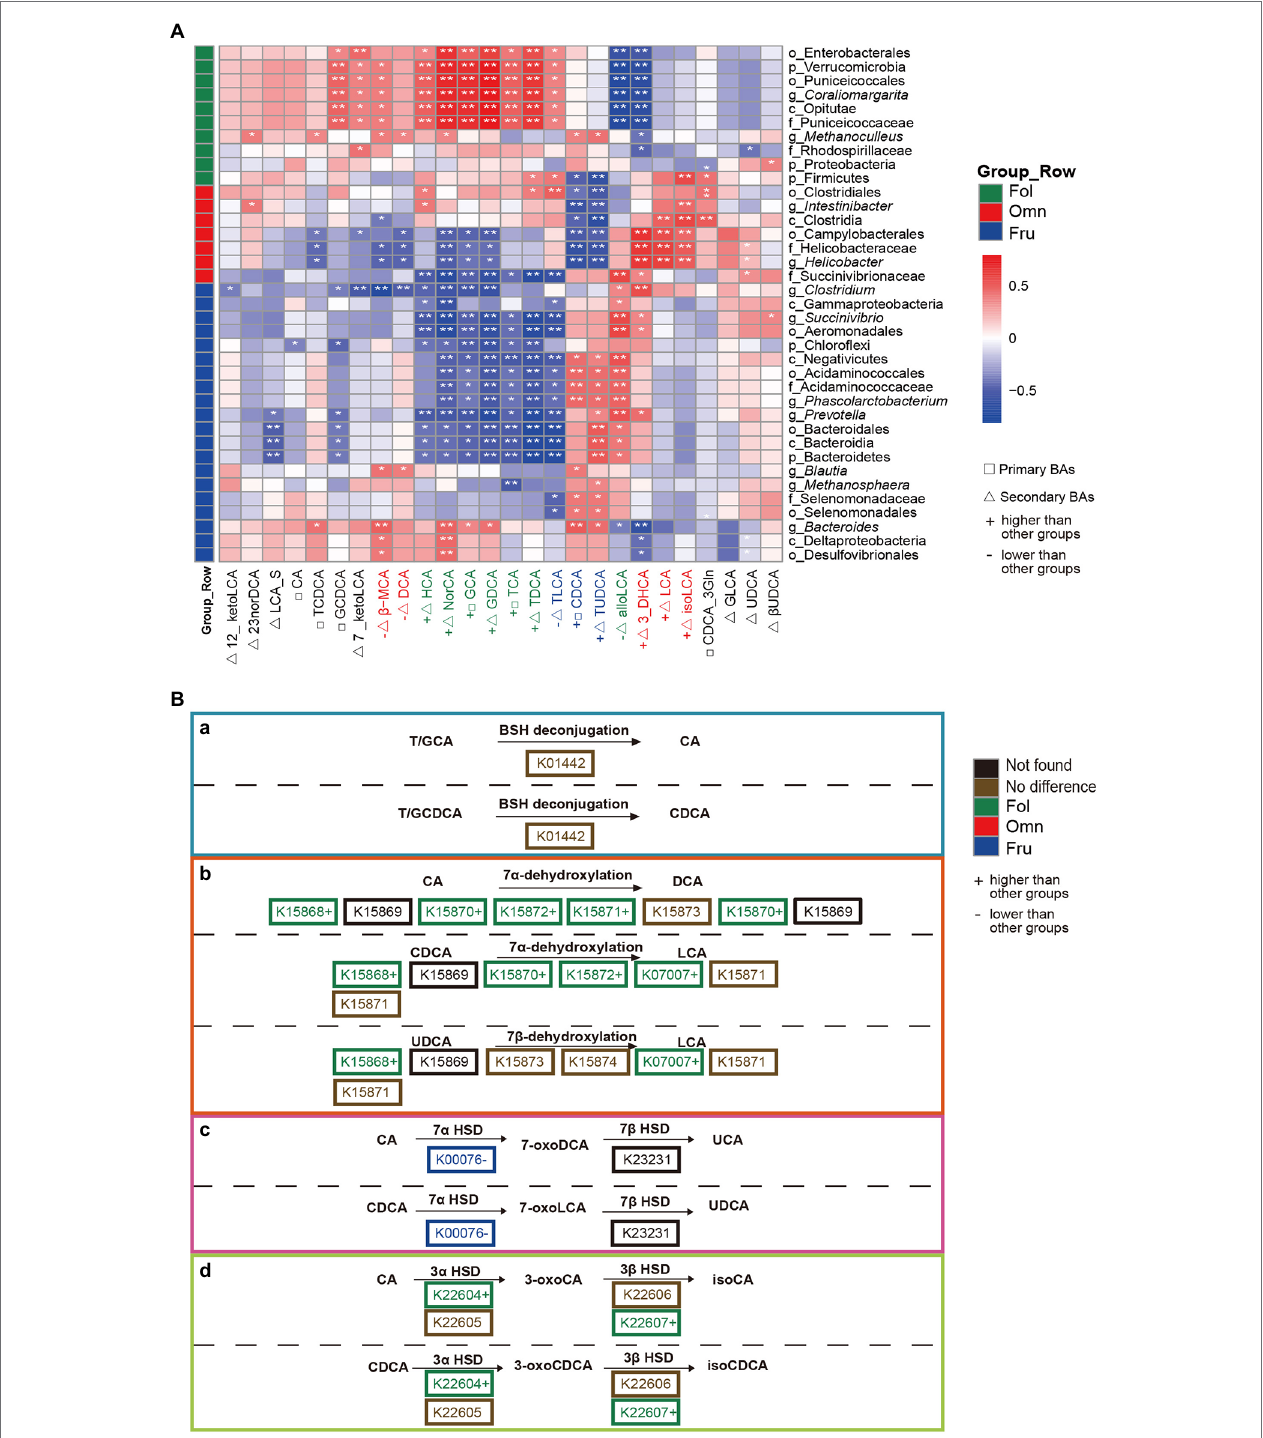
FIGURE 4 | Association between BAs composition and gut microbial diversity. (A) Heat map summarizing the correlations of fecal bile acid concentrations and differentially abundant taxa relative abundance between groups (* p < 0.05; ** p < 0.01). (B) Secondary BAs metabolic pathways modified by the microbiome. (a) BSH deconjugation of T/GCA and T/GCDCA. (b) 7 α / β -dehydroxylation of CA and CDCA. (c) 7 α / β -dehydrogenation of CA and DCA. (d) 3 α / β -dehydrogenation of CA and CDCA. The hydrolysis of taurine or glycine conjugated BAs to free BAs is performed by the bacterial bile salt hydrolase (BSH; K01442; Di Ciaula et al., 2017). In addition, following deconjugation, gut microbiota can perform 7-dehydroxylation, involving a multistep biochemical pathway found only in anaerobic gut bacteria (7-dehydroxylation: K15868, K15869, K15870, K15871, K15872, K15873, K15874, and K07007; Monte et al., 2009), bacterial dehydratases of the anaerobic